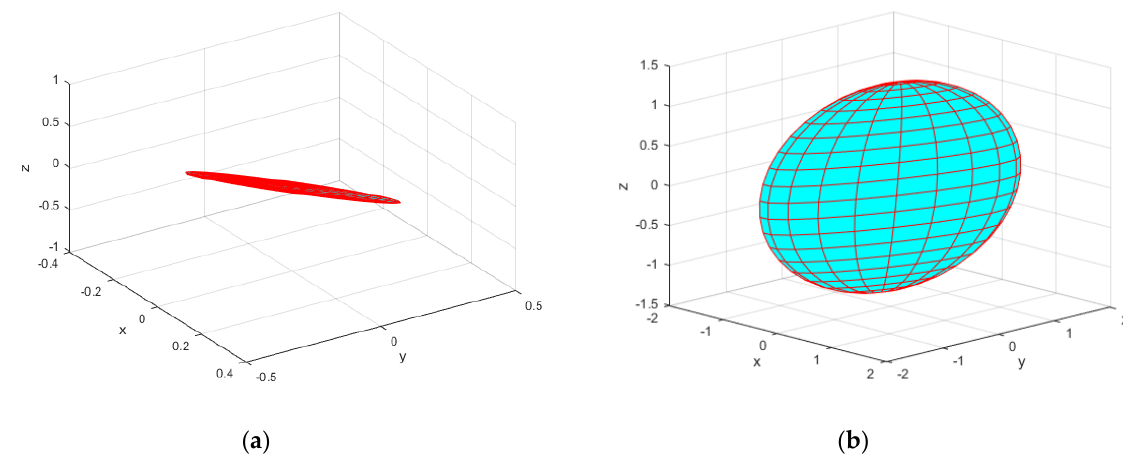
Figure 15. The EE velocity ellipsoid with d 1 = 0.3, q 2 = q 3 = 0 ( ± π ) , q 5 = ± π /2, and q 4 = q 6 = q 7 = π /3. ( a ) Translational velocity ellipsoid; the ellipsoid is an elliptical plate. ( b ) Rotational velocity ellipsoid.